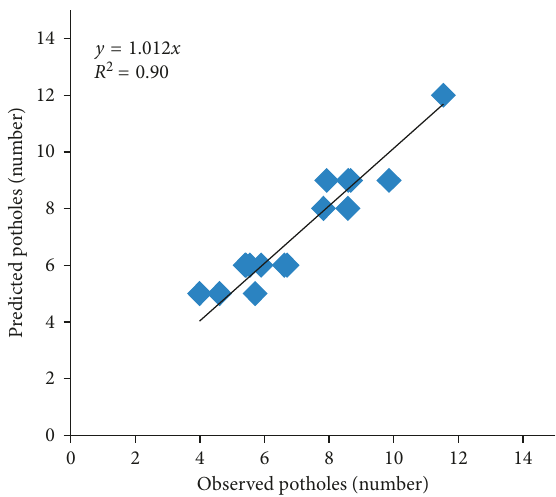
Figure 26: Scatter plot between observed versus predicted rutting for validation (2015).